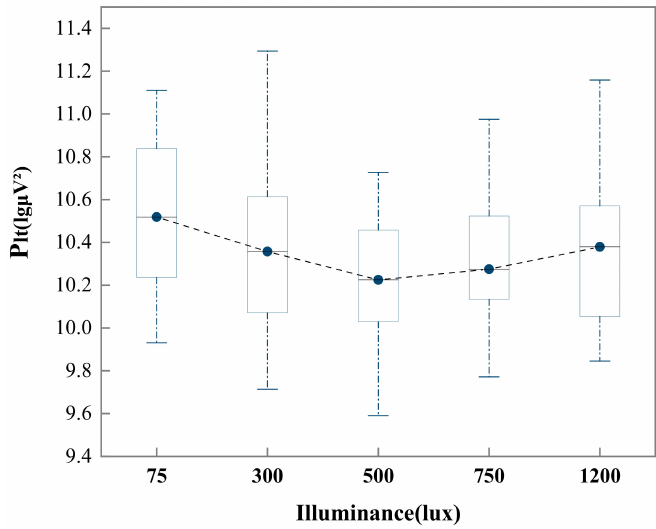
Figure 11. P lt at different